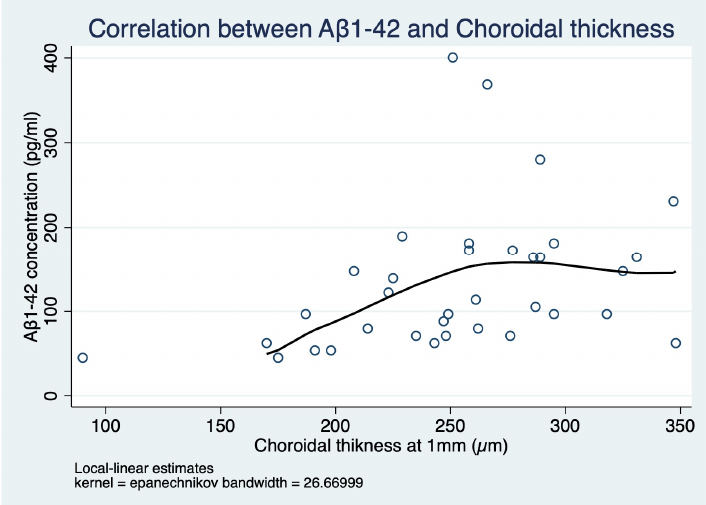
Figure 6. Conditional mean plot after a post hoc analysis that investigated the relationship between A β 1-42 and choroidal thickness (CT). The graph has been generated after a non-parametric kernel regression analysis and overlays the scatterplot of the data.